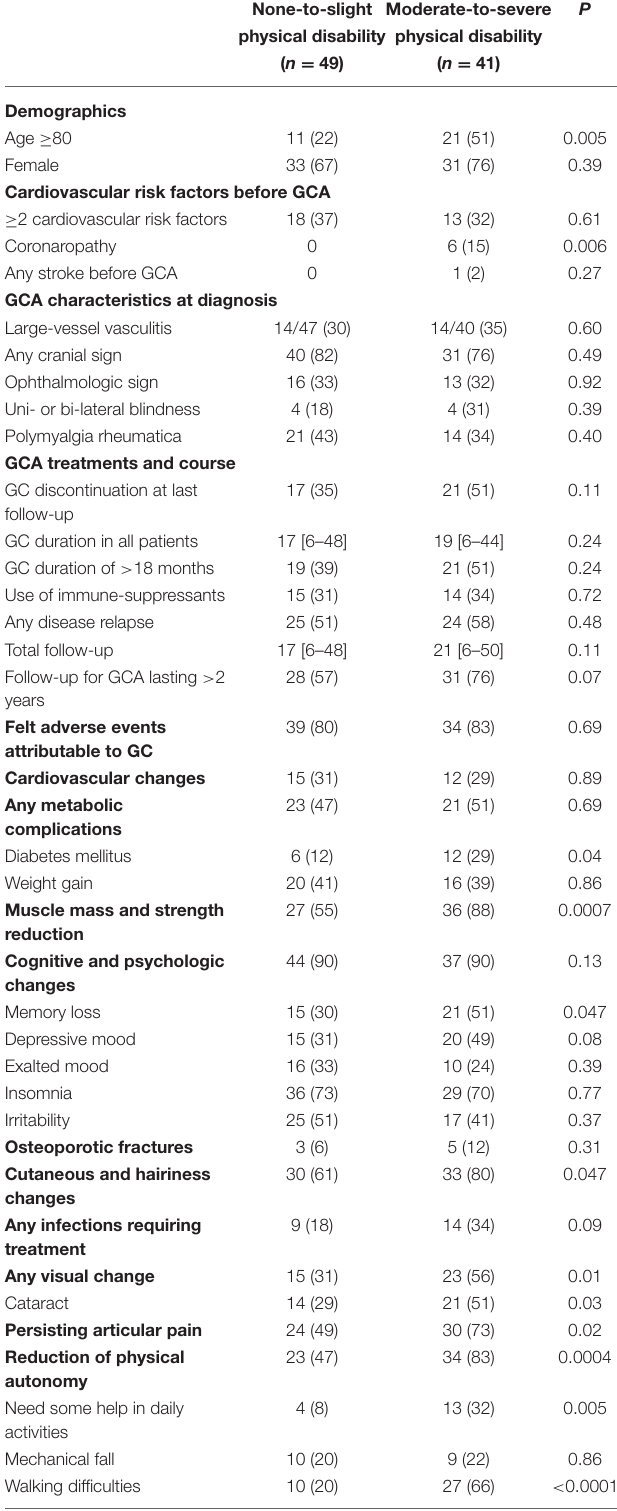
TABLE 1 | Comparison of GCA patients according to the felt severity of physical disability assessed by the SF-12 survey. None-to-slight